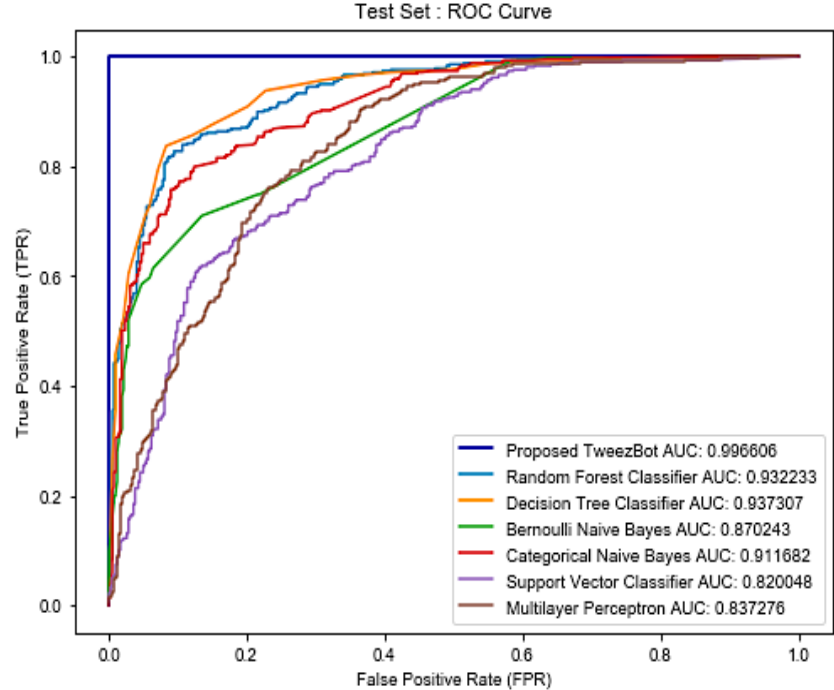
Figure 16. Comparative Analysis of Accuracy for Various Classifiers while Training .